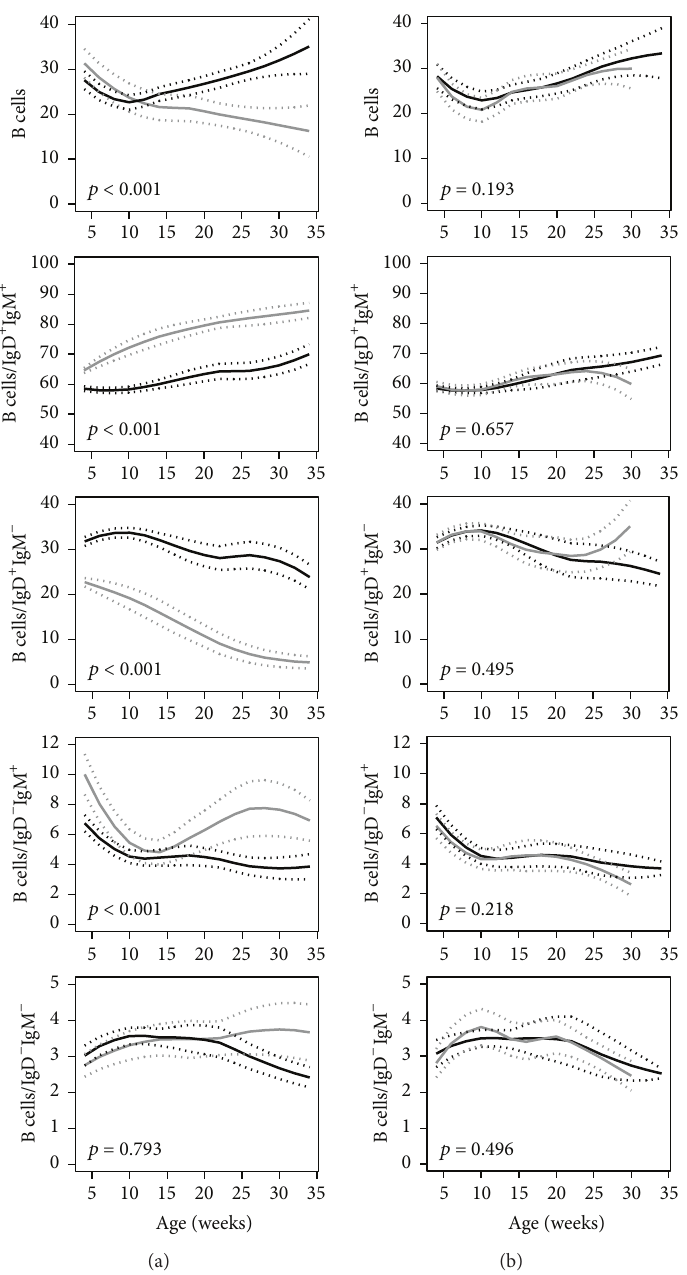
Figure 4: Trajectories of peripheral blood percentages of B lymphocyte populations in (a) NOD mice (black line) versus NOR mice (gray line) and (b) NOD mice that developed diabetes (black line) versus NOD mice that were diabetes-free at age of 36 weeks (gray line). The unbroken lines represent 95% confidence intervals of the trajectories. 𝑝 values for the comparisons are shown in each